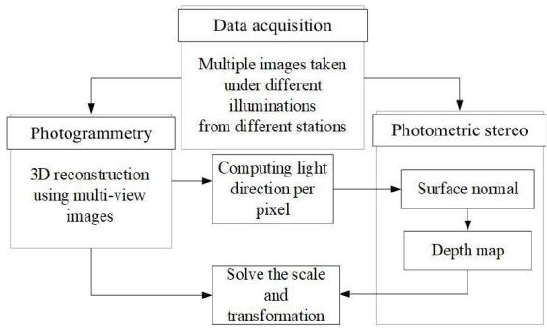
Figure 2. An overview of the proposed integrated